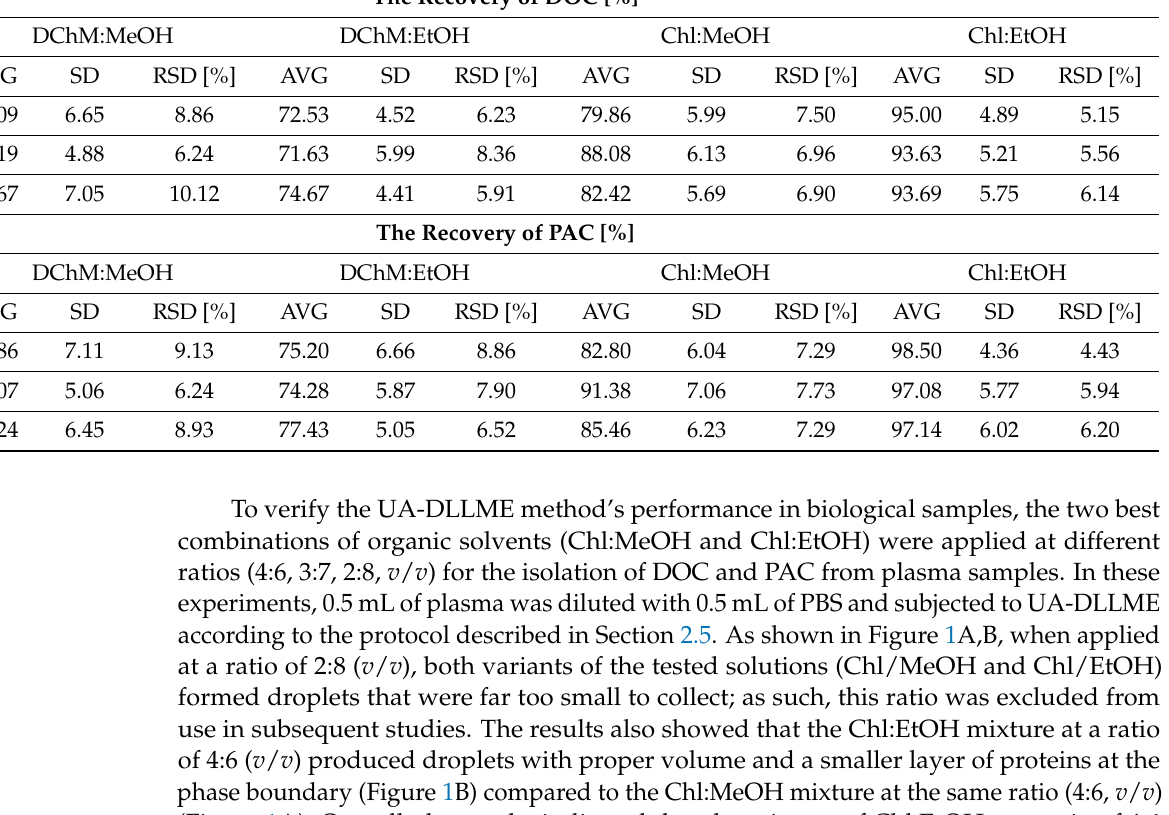
Table 1. Recoveries of DOC and PAC at a concentration of 1000 ng/mL from 1 mL PBS after using different sample preparation (n = 3). The Recovery of DOC [%]